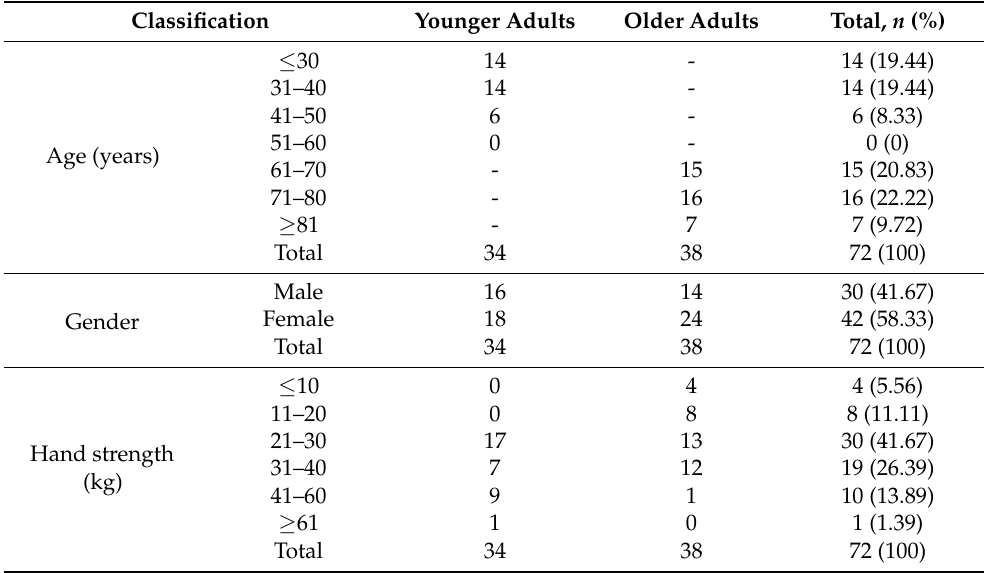
Table 3. Demographic characteristics of